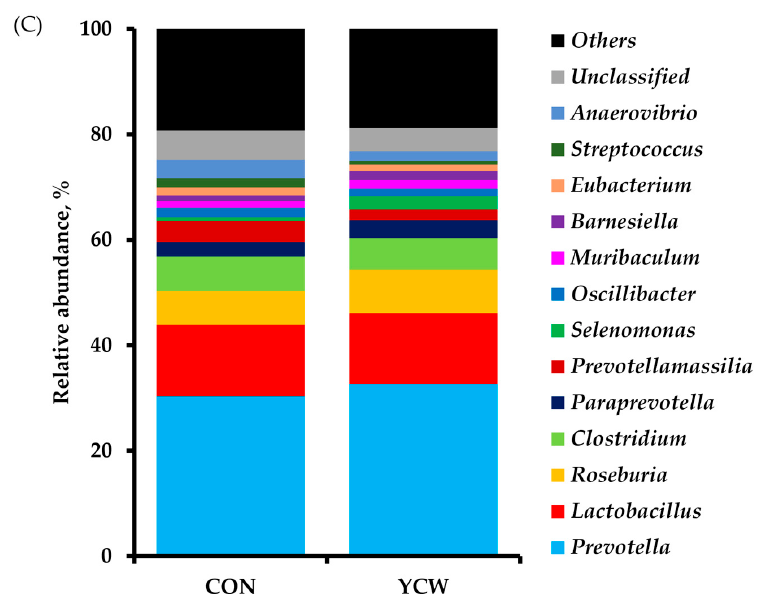
Figure 2. Principal coordinate analysis (PCoA) plot for weighted UniFrac distances in gut microbial communities from piglets’ feces of each dietary treatment ( A ). Taxonomic composition shows relative abundance of fecal microbiota in each treatment group at phylum level ( B ) and genus ( C ) level. n = 3. CON = a basal nursery diet (red, ○ ); YCW = CON with 0.05% dietary yeast cell wall (blue, □ ).